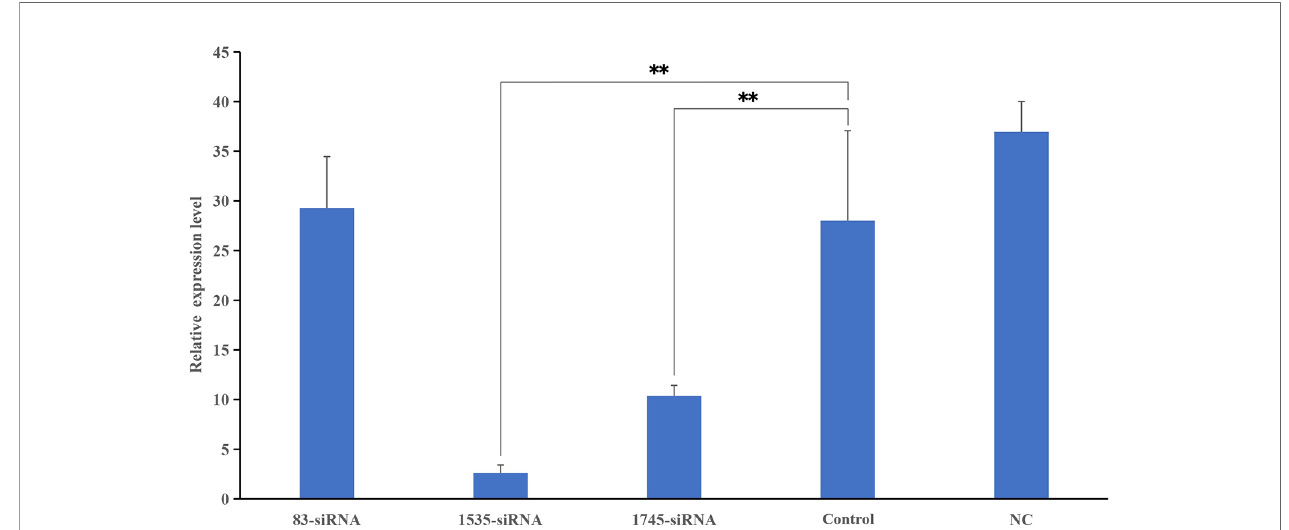
FIGURE 6 | Knockdown ef fi ciency detected by Real-time PCR. The relative expression levels of pf-C3 after RNA interference, PBS as control. Signi fi cant difference was indicated by asterisks, ** P <